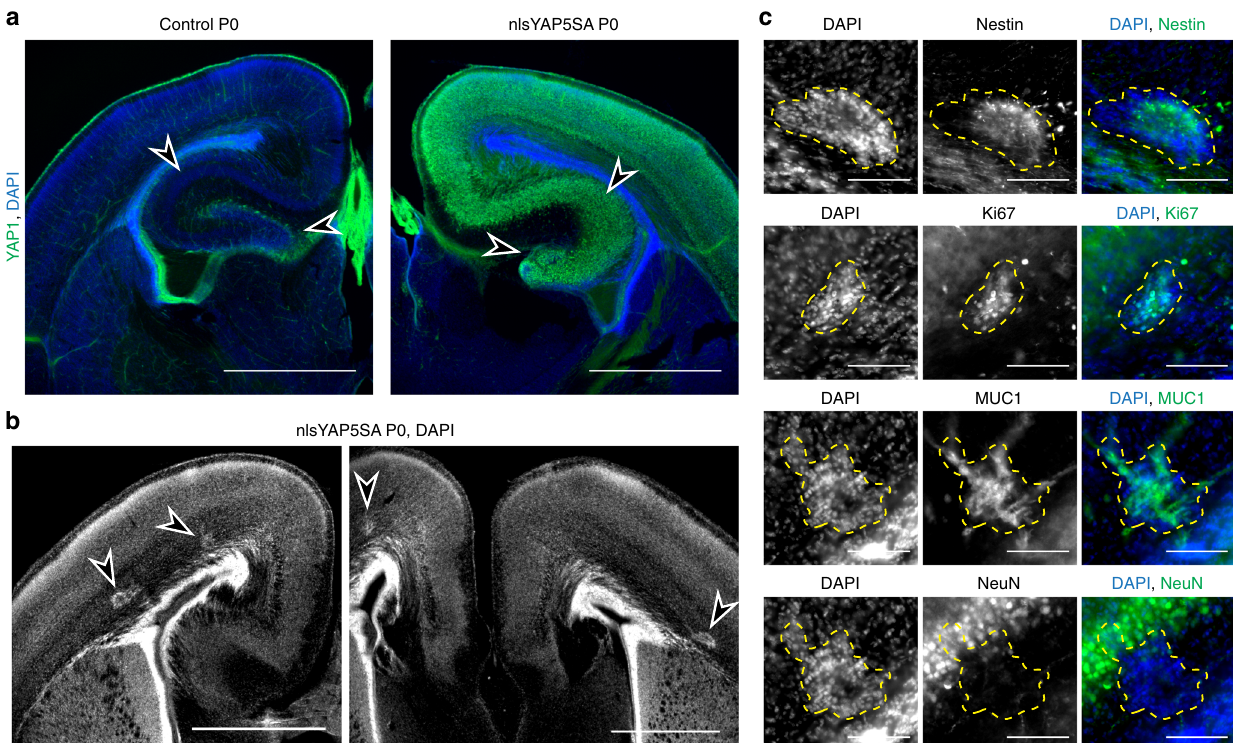
Fig. 2 Uncontrolled YAP1 in NEX-Cre-expressing cells is suf fi cient for tumour formation at the expense of hippocampal differentiation. a Immuno fl uorescence staining of YAP1 in coronal vibratome sections of P0 animals. Neurons in nlsYAP5SA mouse cortex show strong nuclear staining of YAP1. Hippocampus formation is altered in nlsYAP5SA (arrowheads). Scale bars = 1 mm. b Arrowheads pointing at tumours visible in coronal vibratome sections of a P0 nlsYAP5SA animal. Scale bars = 1 mm. c Immuno fl uorescence staining in coronal sections of tumours in a nlsYAP5SA mice. Tumours are outlined with yellow-dashed line. Nestin, Ki67 and MUC1 demonstrate highly intense staining in the tumours while NeuN is absent. Scale bars = 100 µ